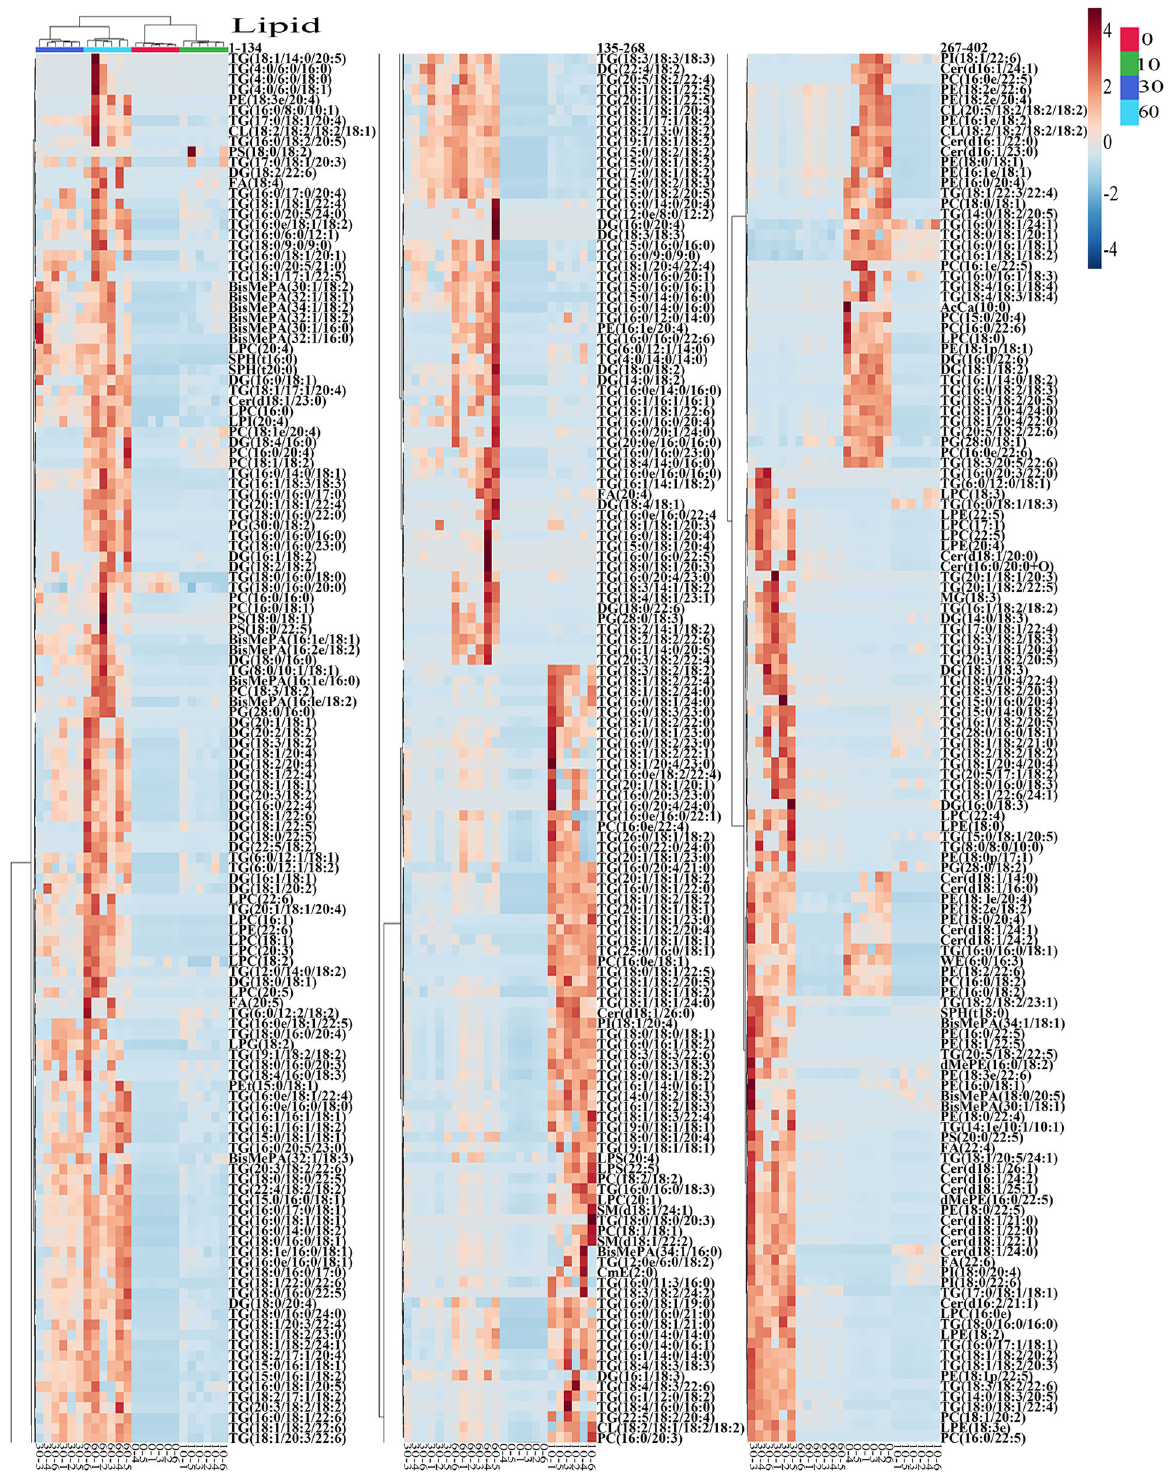
Fig. 8 Heap map of the sum individual lipids in tilapia muscle and juice at different steaming times by Metaboanalyst 5.0 software according to the normalized MS data. Each colored cell in the heat map corresponds to a peak area value of the individual lipid on the right side. In the colored cells, red color is high and blue color is